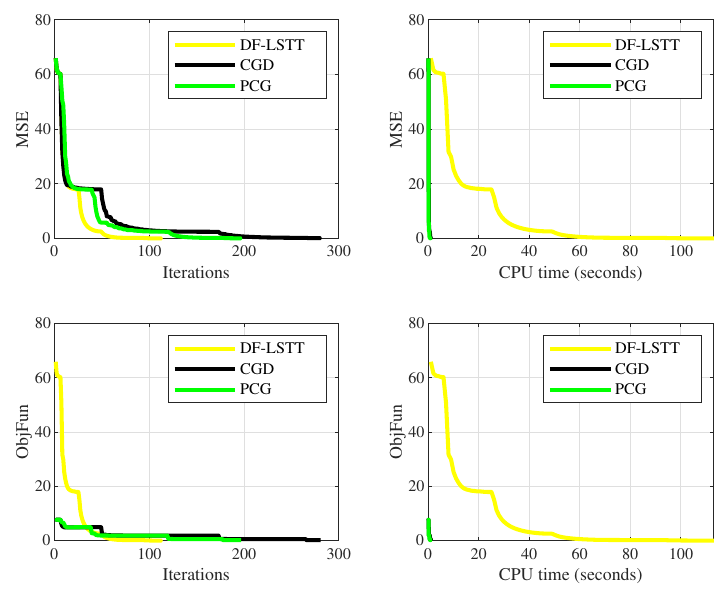
Figure 2. Comparison results of the DF-LSTT, CGD, and PCG algorithms with the signal parameter chosen as n = 2048, m = 512, τ = 0.00396321. The x -axes represent the number of iterations ( top left and bottom left ) and the CPU time in seconds ( top right and bottom right ). The y -axes represent the MSE ( top left and top right ) and the function values ( bottom left and right ).